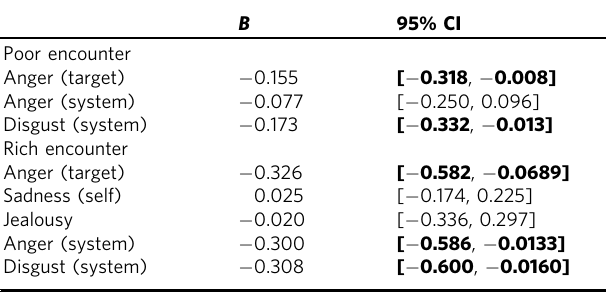
Table 9 Indirect effects of conservatism on inequality treatment effects mediated by economic system justi fi cation in Study